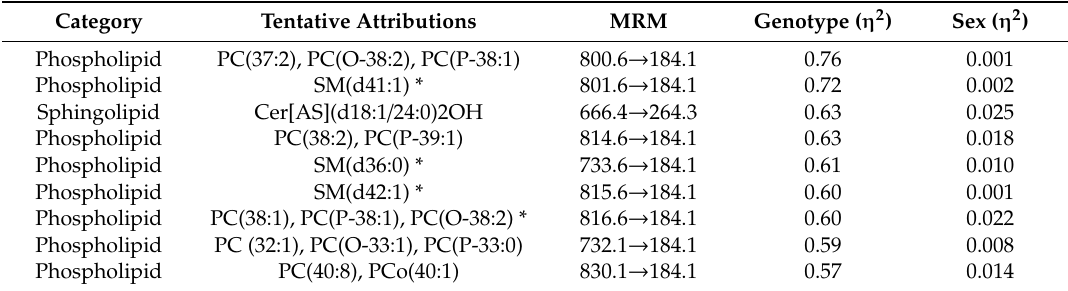
Table 1. List of top 10 lipid ions ranked by the e ff ect size of the univariate models linking genotype with the lipidomic profile.